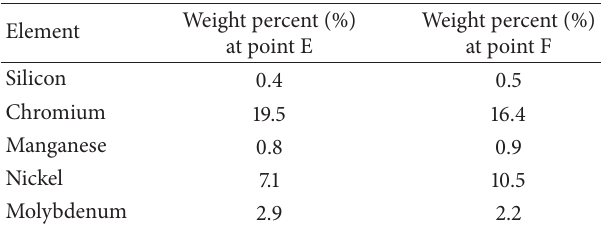
Figure 9: The fracture locations of EBW-welded specimens after tensile tests. Table 7: The EDS analyses from matrix and grain boundary in AISI 316L heat affected zone